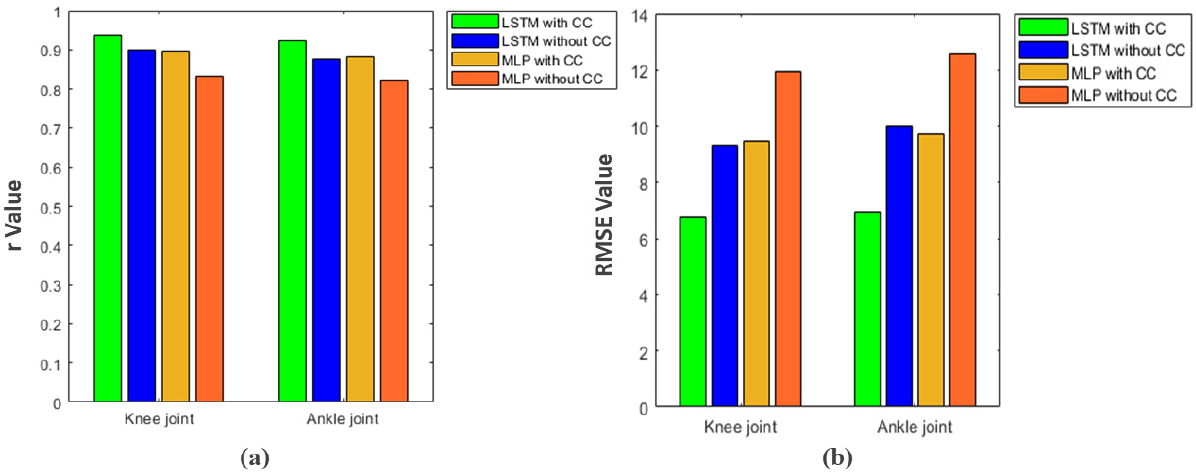
Figure 9. Investigating the effect of cross-correlation analysis and considering the delay of sEMG signal in two networks in both joints, ( a ) correlation coefficient value ( r ); ( b ) RMSE value